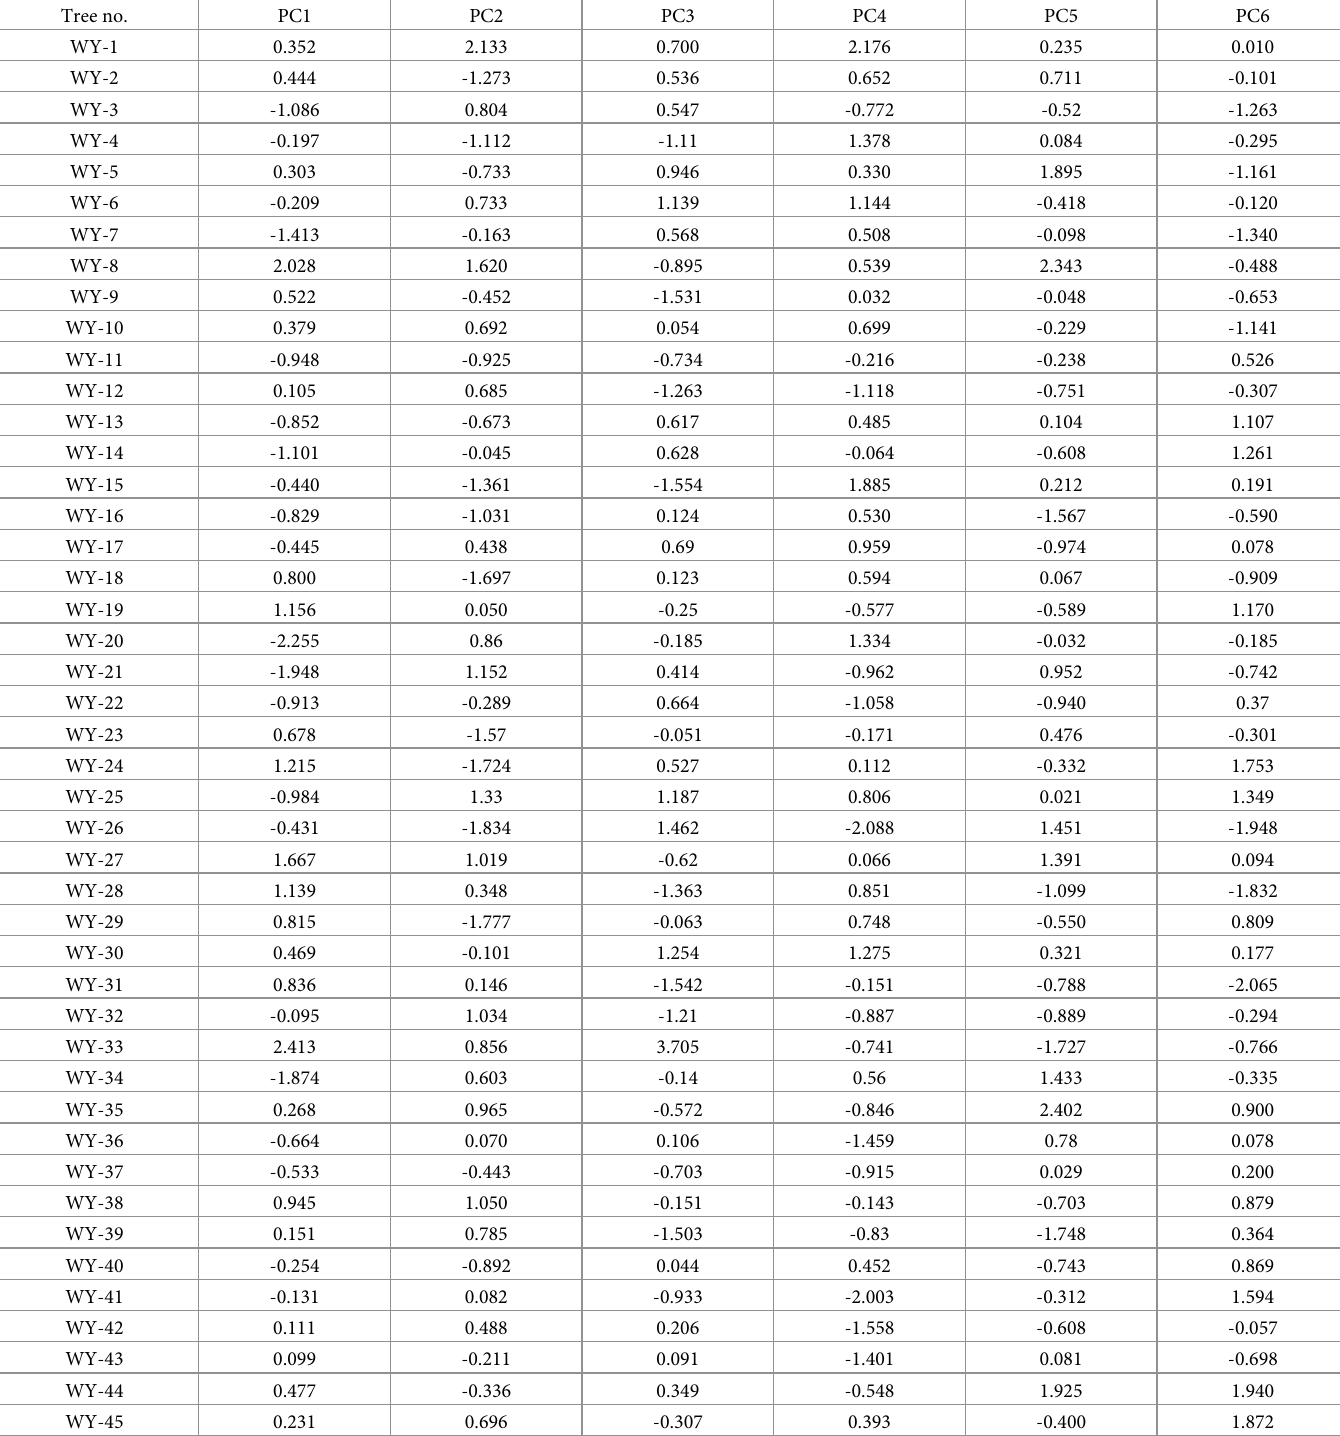
Table 3. Scores of the 45 C . weiningensis trees on the six principal components. Tree